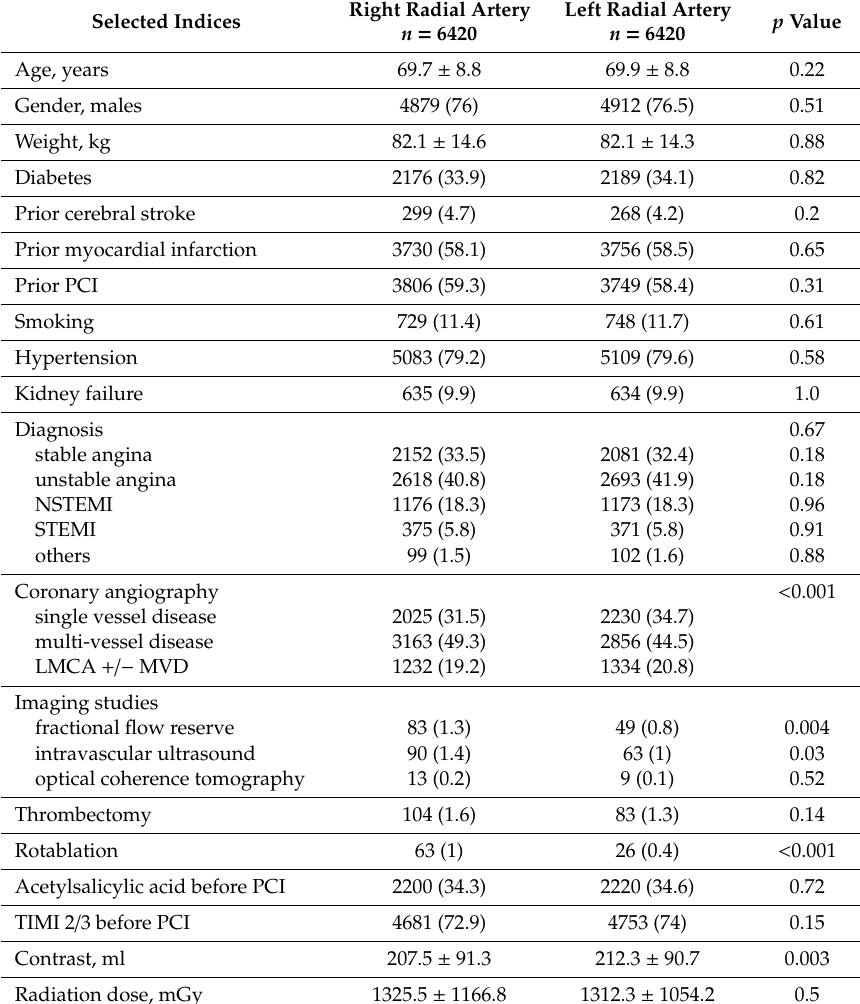
Table 4. General patient characteristics according to right and left radial access in the overall group of patients following propensity score